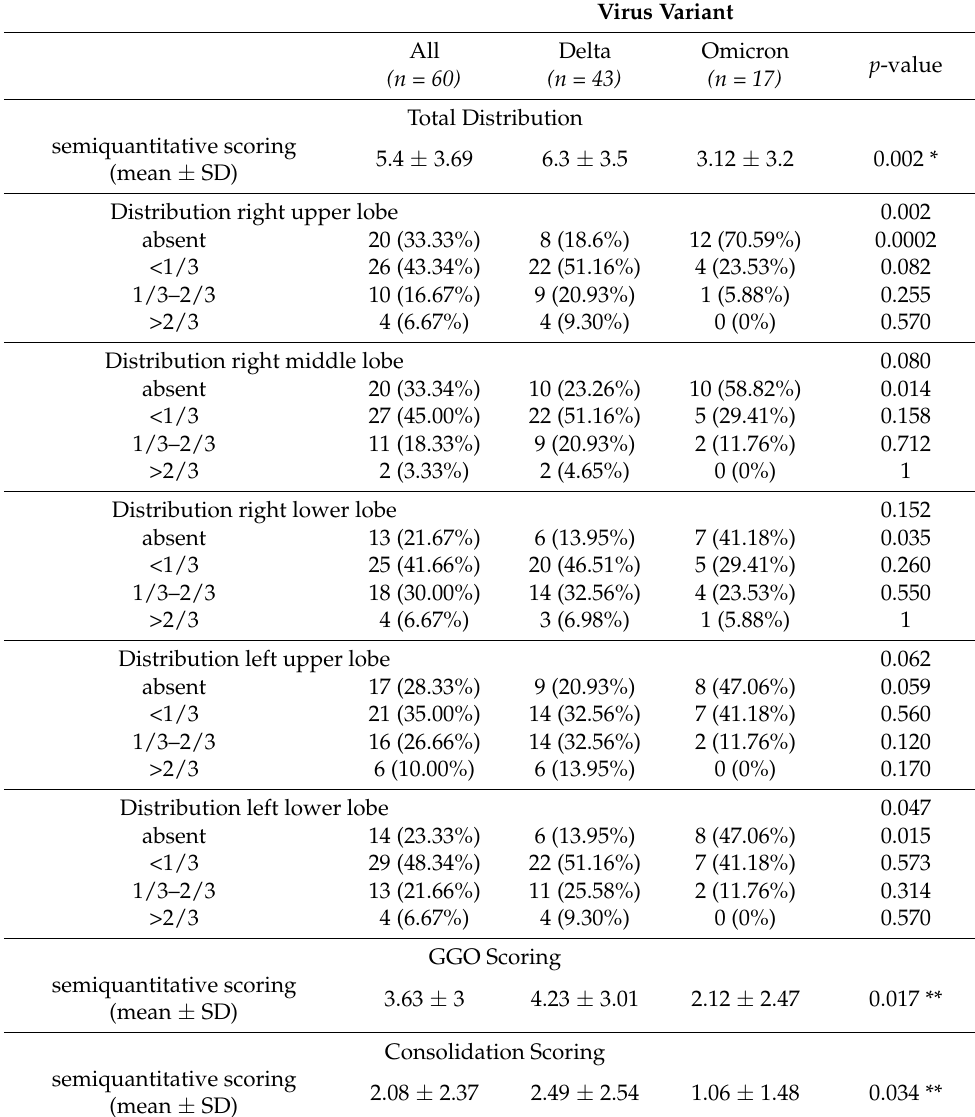
Table 4. Semiquantitative scoring: CT-graphic pulmonary manifestation of COVID-19 infection according to virus